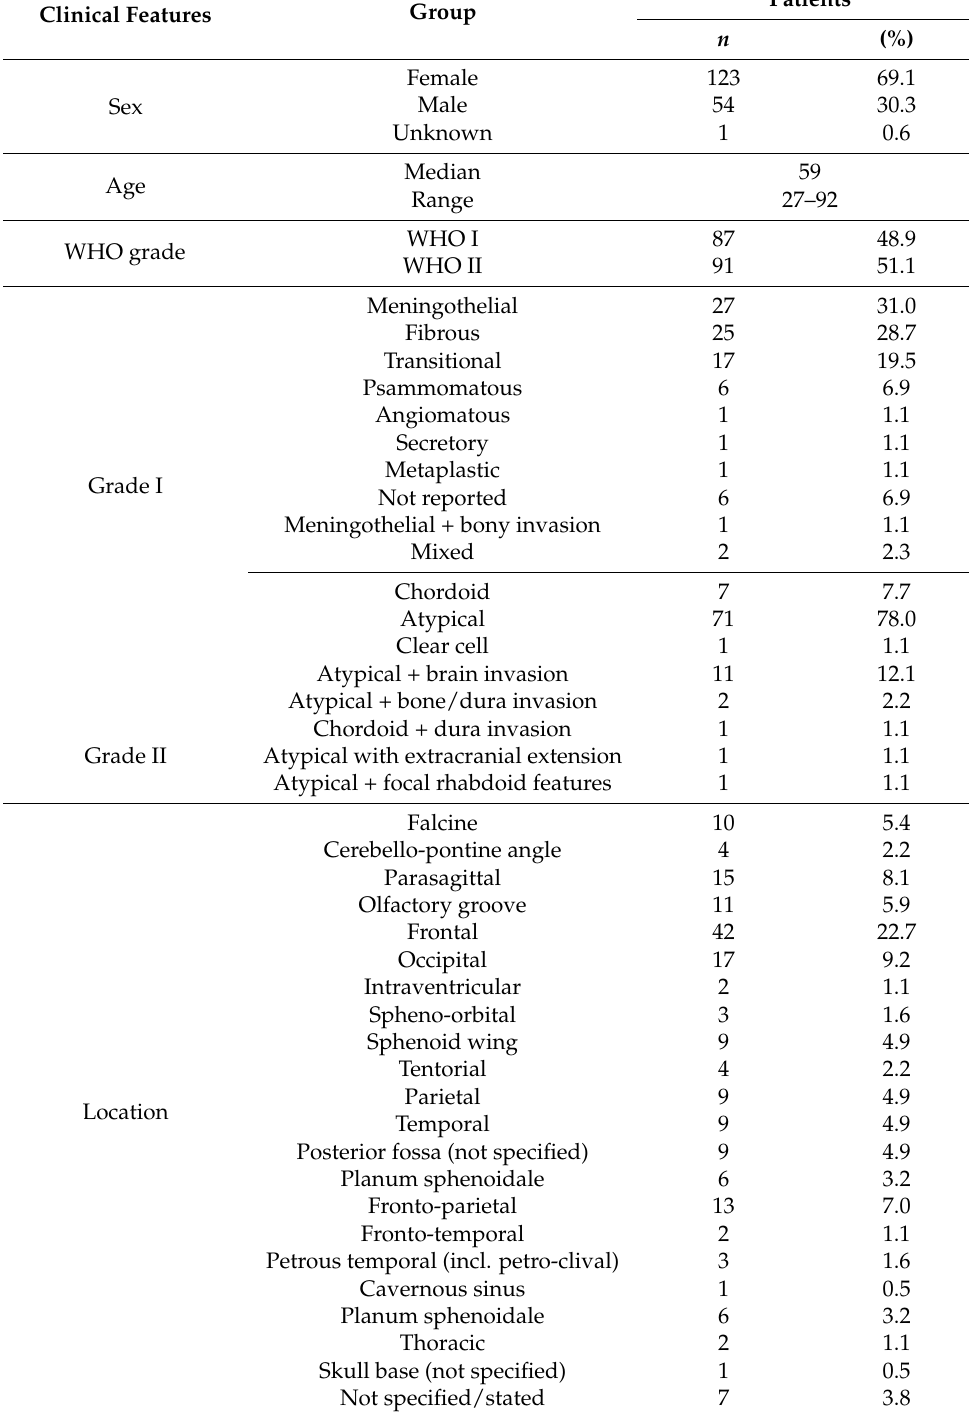
Table 1. Clinical characteristics of the meningioma samples used ( n = 178). There were two grade I meningioma patients with mixed histology; one had metaplastic, transitional and microcystic (sphenoid wing) and transitional (frontal) tumours; the other had a mixed meningothelial, microcystic and angiomatous